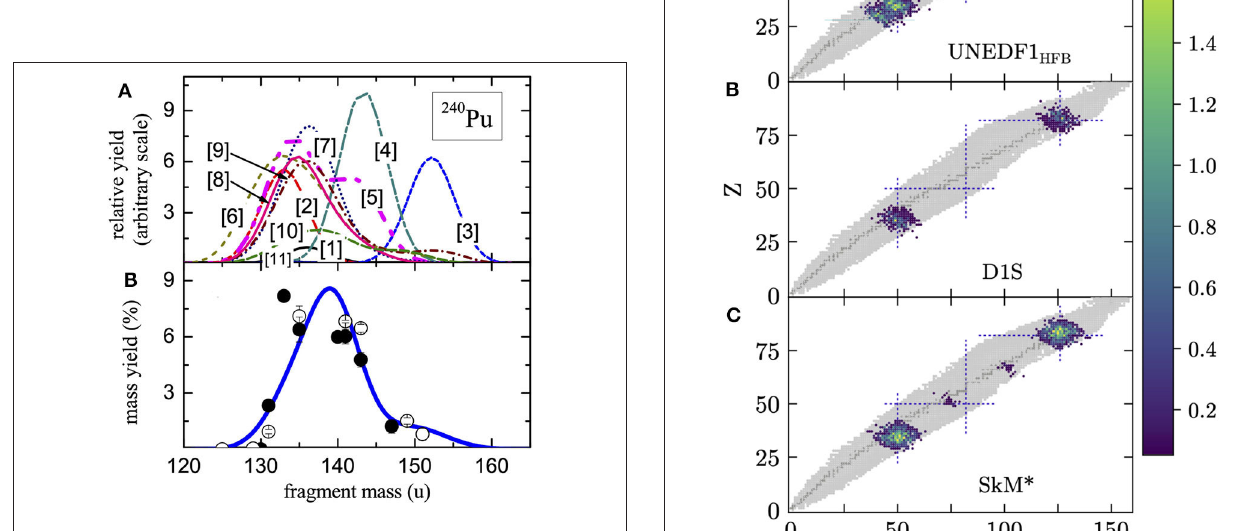
Frontiers in Physics |